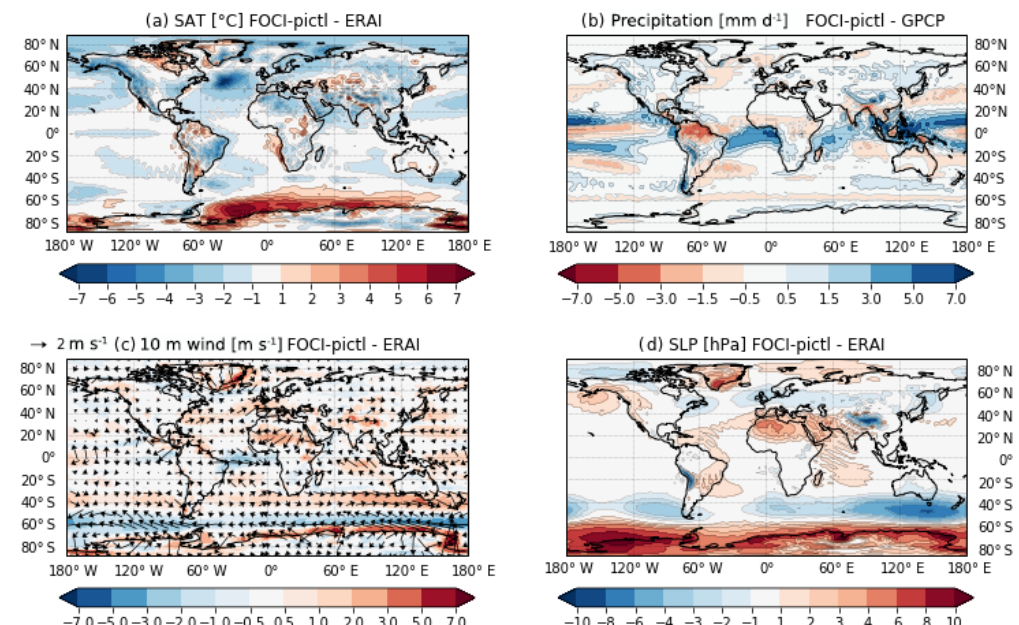
Figure 4. Annual mean biases for the FOCI-piCtl simulation for (a) surface air temperature in Kelvin (K), (b) precipitation in millimeters per day (mmd − 1 ), (c) 10m wind in meter per second (ms − 1 ) and (d) 500hPa geopotential height (Z500) in hPa with respect to ERA-Interim ( a, c, d , 1980–2013) or the GPCP dataset ( b , 1980–2013). Please note the reversed color scale panel (b) to highlight dry (wet) areas in shades of red (blue) compared to GPCP.